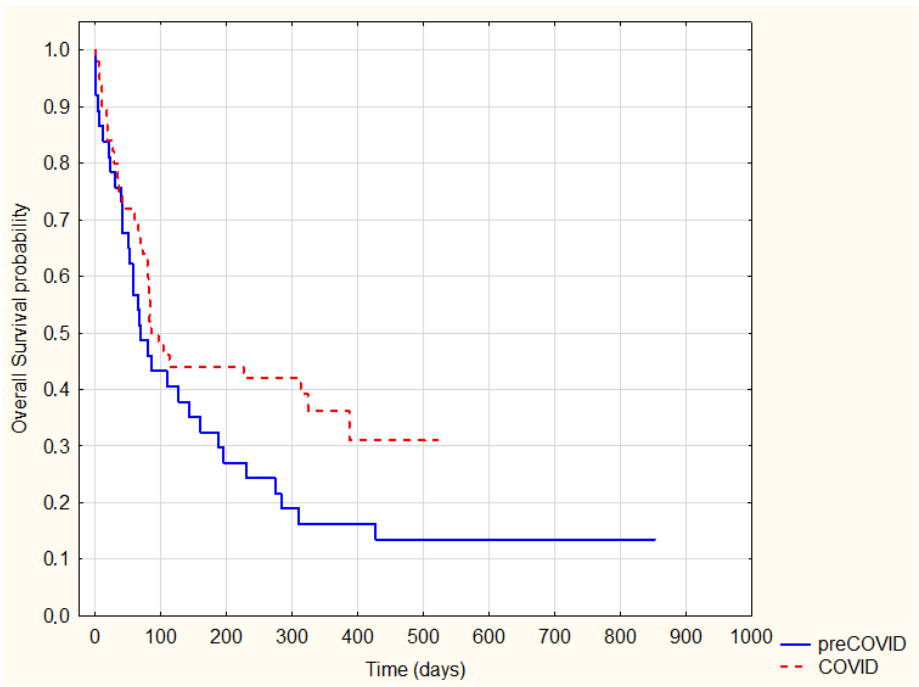
Figure 5. Kaplan–Meier Survival Analysis—adenocarcinoma pre-COVID-19 vs. COVID-19, log-rank p = 0.07.